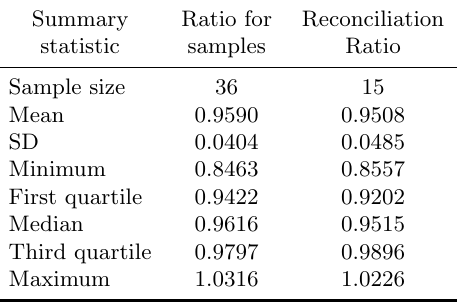
Table 1: Summary of statistics for maize sample and reconciliation